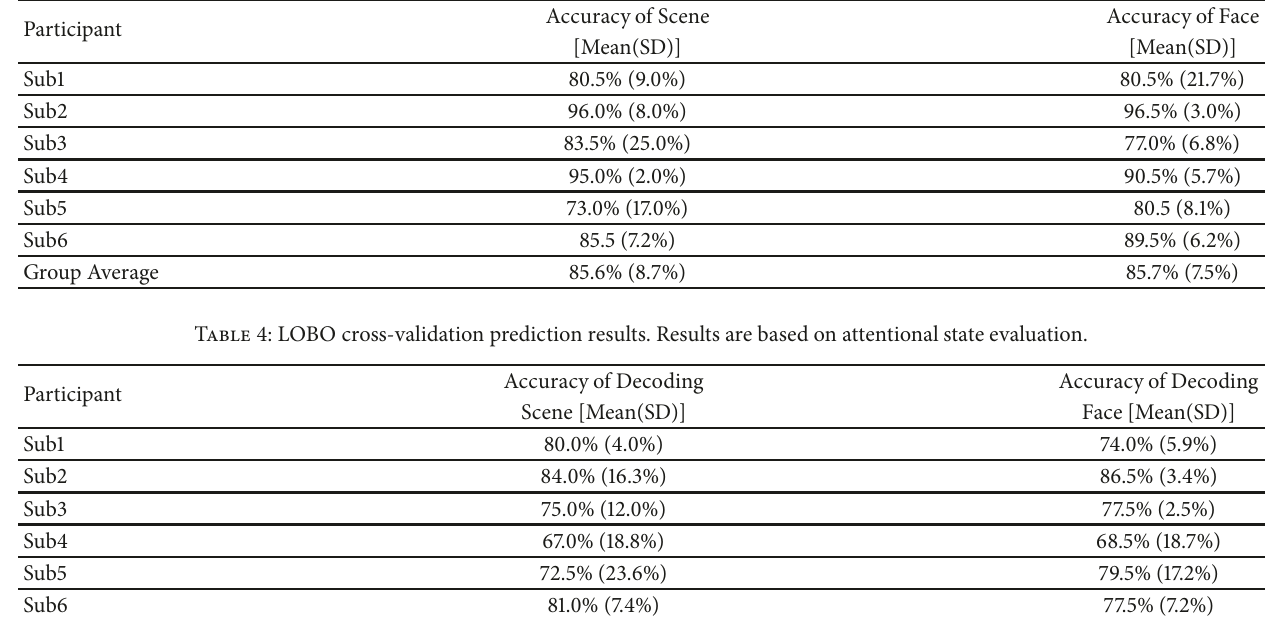
Table 3: Behavioral performance of participants. The percentage of correct mouse clicks (success rate) separated by the stimuli category is given.